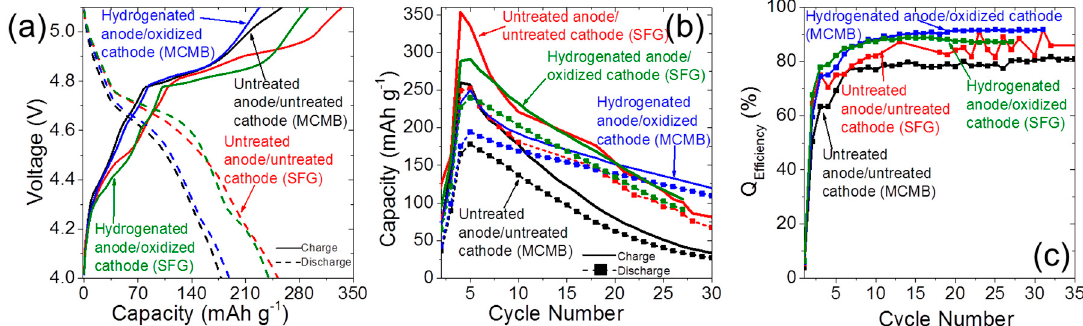
Figure 4. ( a ) Voltage vs. capacity of 1st 4.0–5.1 V cycle of full dual-intercalation cells. In each case, a graphite cathode (either MCMB or SFG) is matched with a graphite anode (CGP); ( b ) Charge/discharge capacity (including pre-conditioning) using C/10 cycles normalized to anode mass; ( c ) Coulombic efficiencies for first 35 cycles.